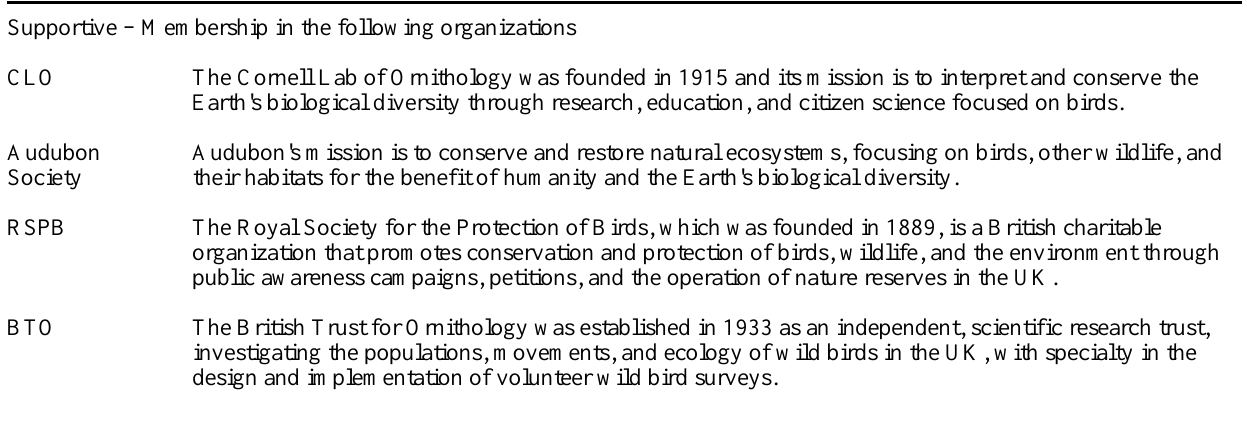
Table 1. Description of data sources on gender patterns in bird-related recreation projects divided into four groups based on the degree of competition (Supportive, Participatory, Competitive, and